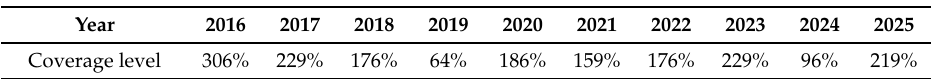
Table 10. The coverage level of demand of gasoline by replacing them with bioethanol. Source: authors’ own calculation based on [56].